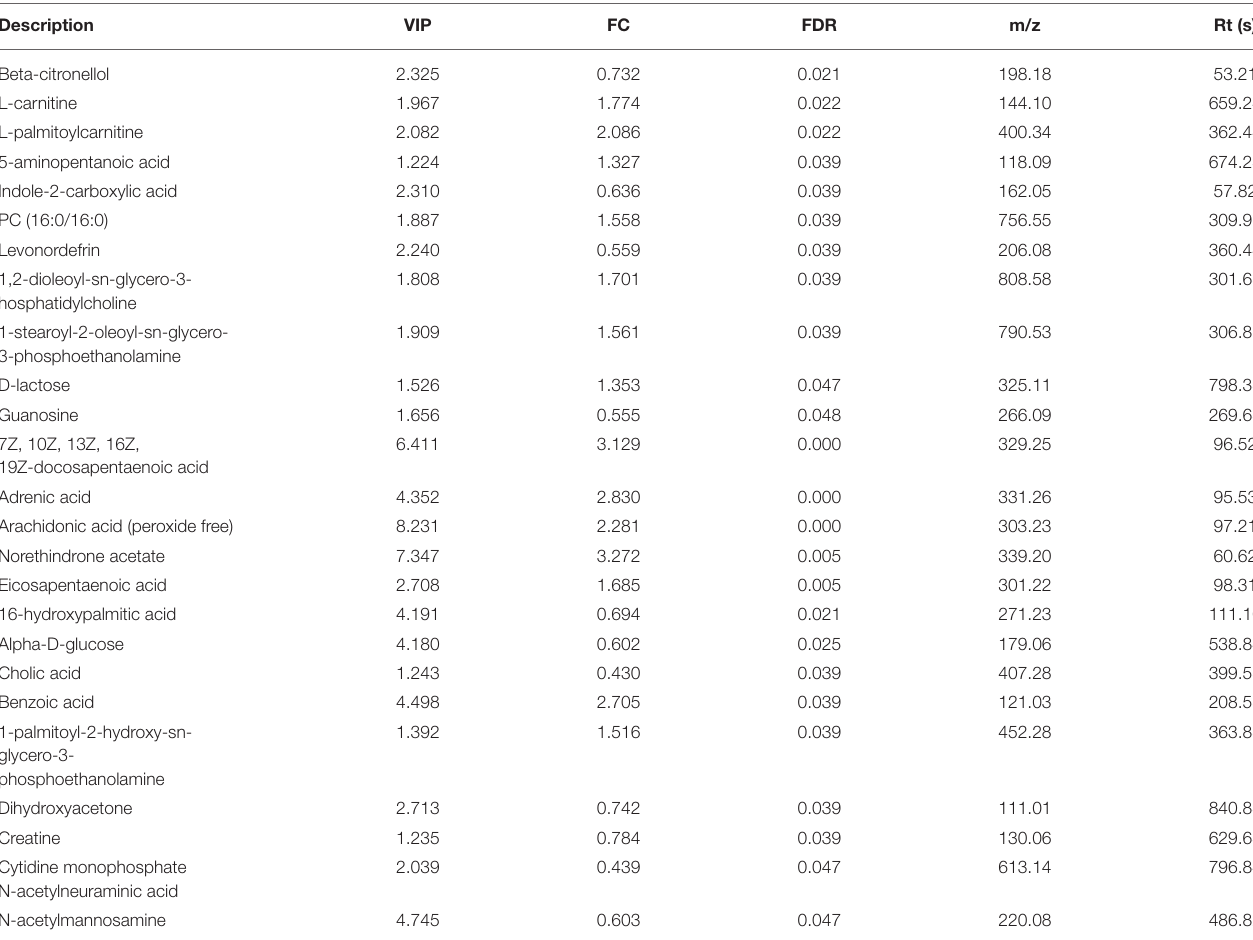
TABLE 4 | Differential metabolites in milk between the EUL and CTR groups ( n = 10, CTR and n = 8, EUL). Description